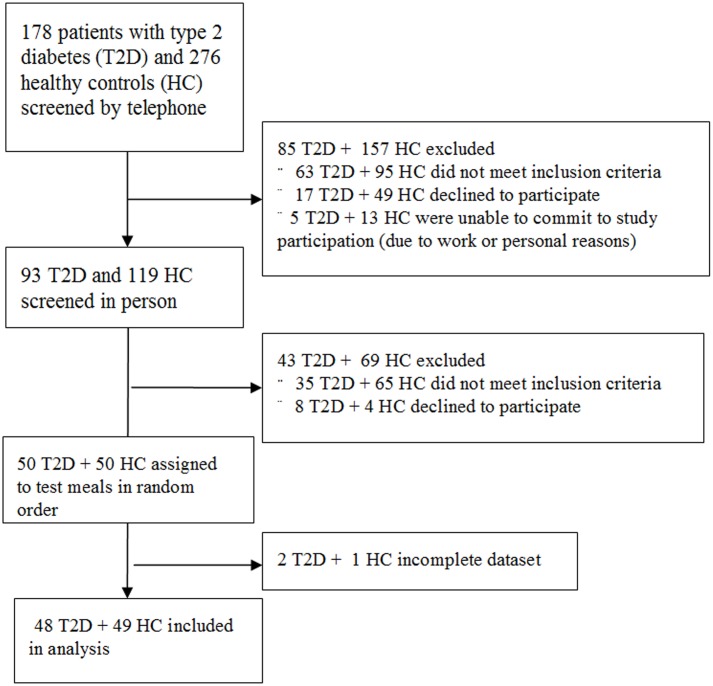
Enrollment of the participants and completion of the study.